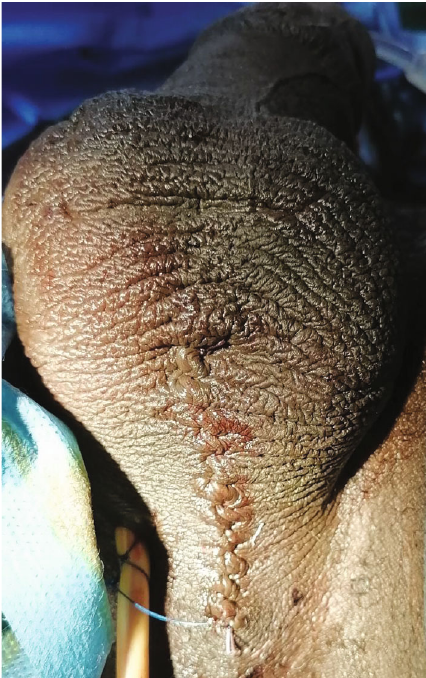
Figure 9: Final wound closure with a catheter drain left in situ.